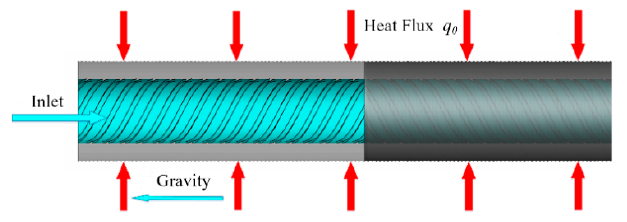
Figure 2. Schematic of the physical model and structure. Table 2. The rib structural parameters of specific IRT. Structural